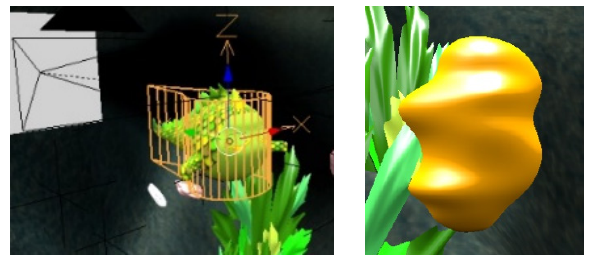
Fig. 8: Details of “Dive and Eat”. Left: Phiby with Avatar grid. Right: Plankton.